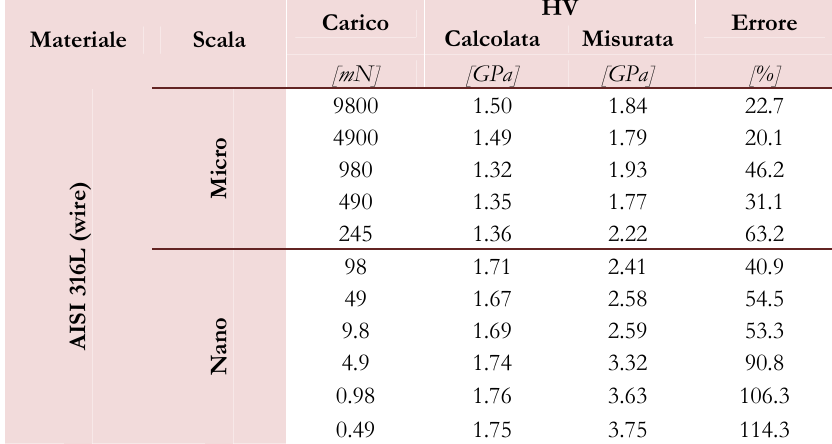
Table 4: Comparison between the experimental values of the Vickers hardness and the corresponding values determined by solving elasto-plastic FE models calibrated through the Ramberg-Osgood curve generated by testing microscopic samples of AISI 316L. A conclusione di quanto riportato nel presente paragrafo, si può rimarcare come la durezza superficiale dei materiali metallici possa essere stimata correttamente ricorrendo alla sola meccanica del continuo fintanto che la dimensione